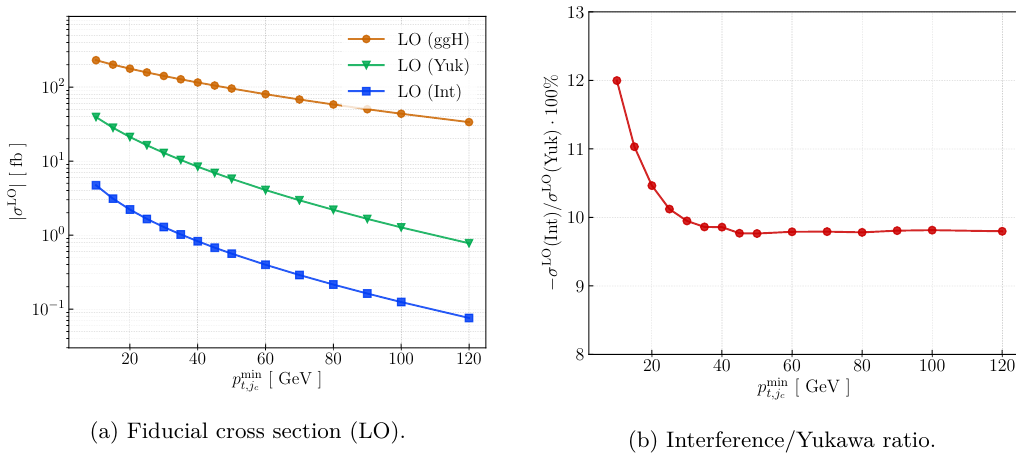
Figure 2 . Leading-order cross sections computed for different values of the charm-jet p t -cut. We show Yukawa-like (green) and ggH -like (orange) contributions as well as the absolute value of the interference (blue). In the right pane the ratio of the interference and the Yukawa-like fiducial cross section are